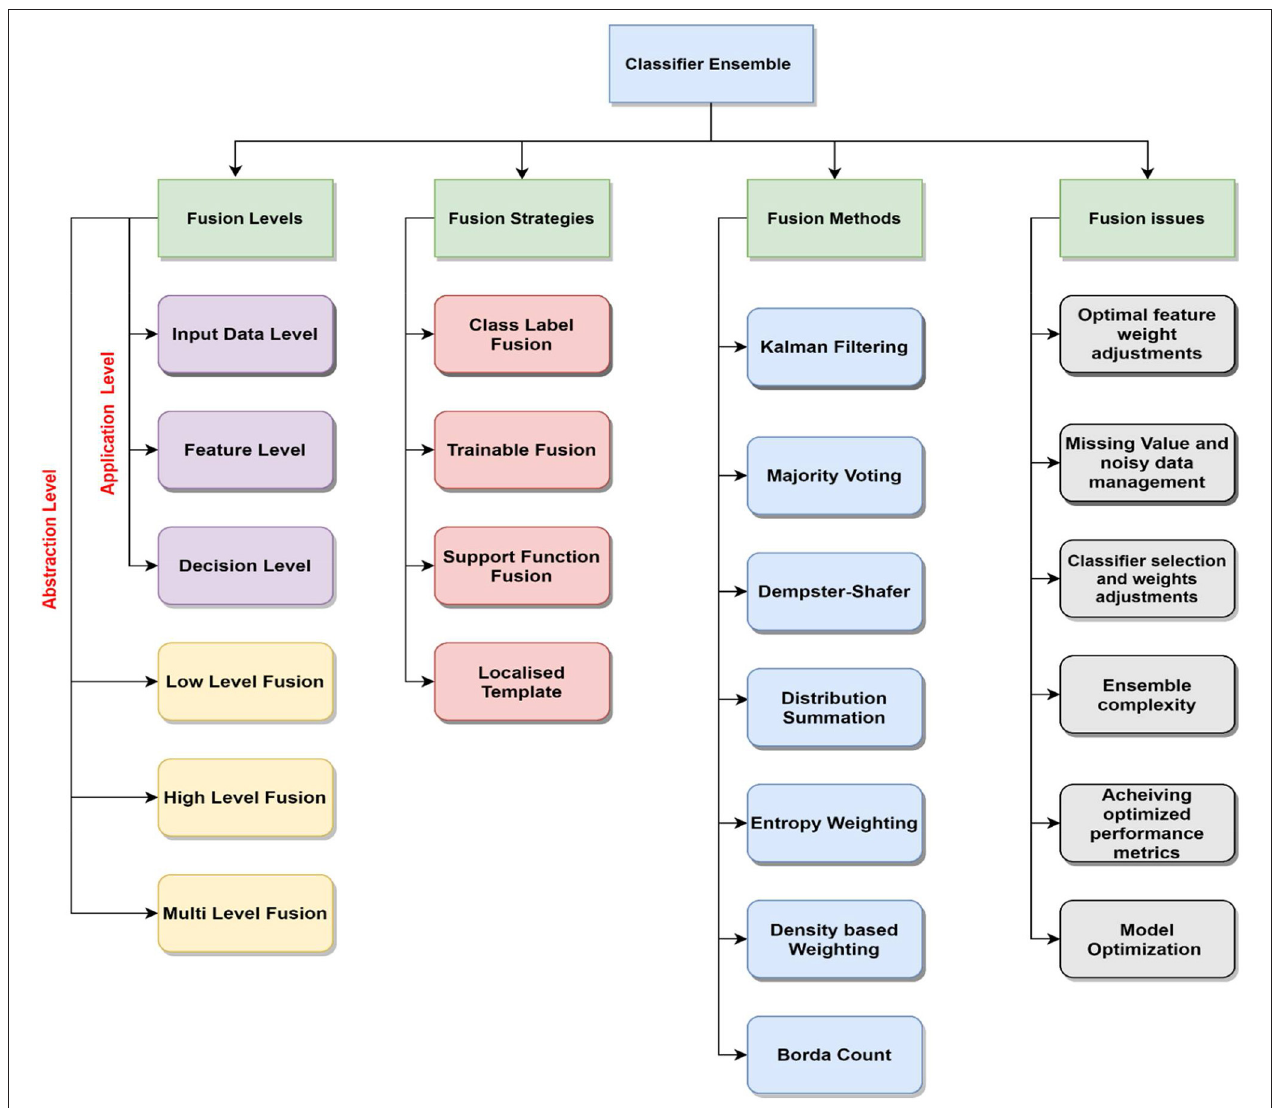
FIGURE 1 | Overview of existing classifier ensemble